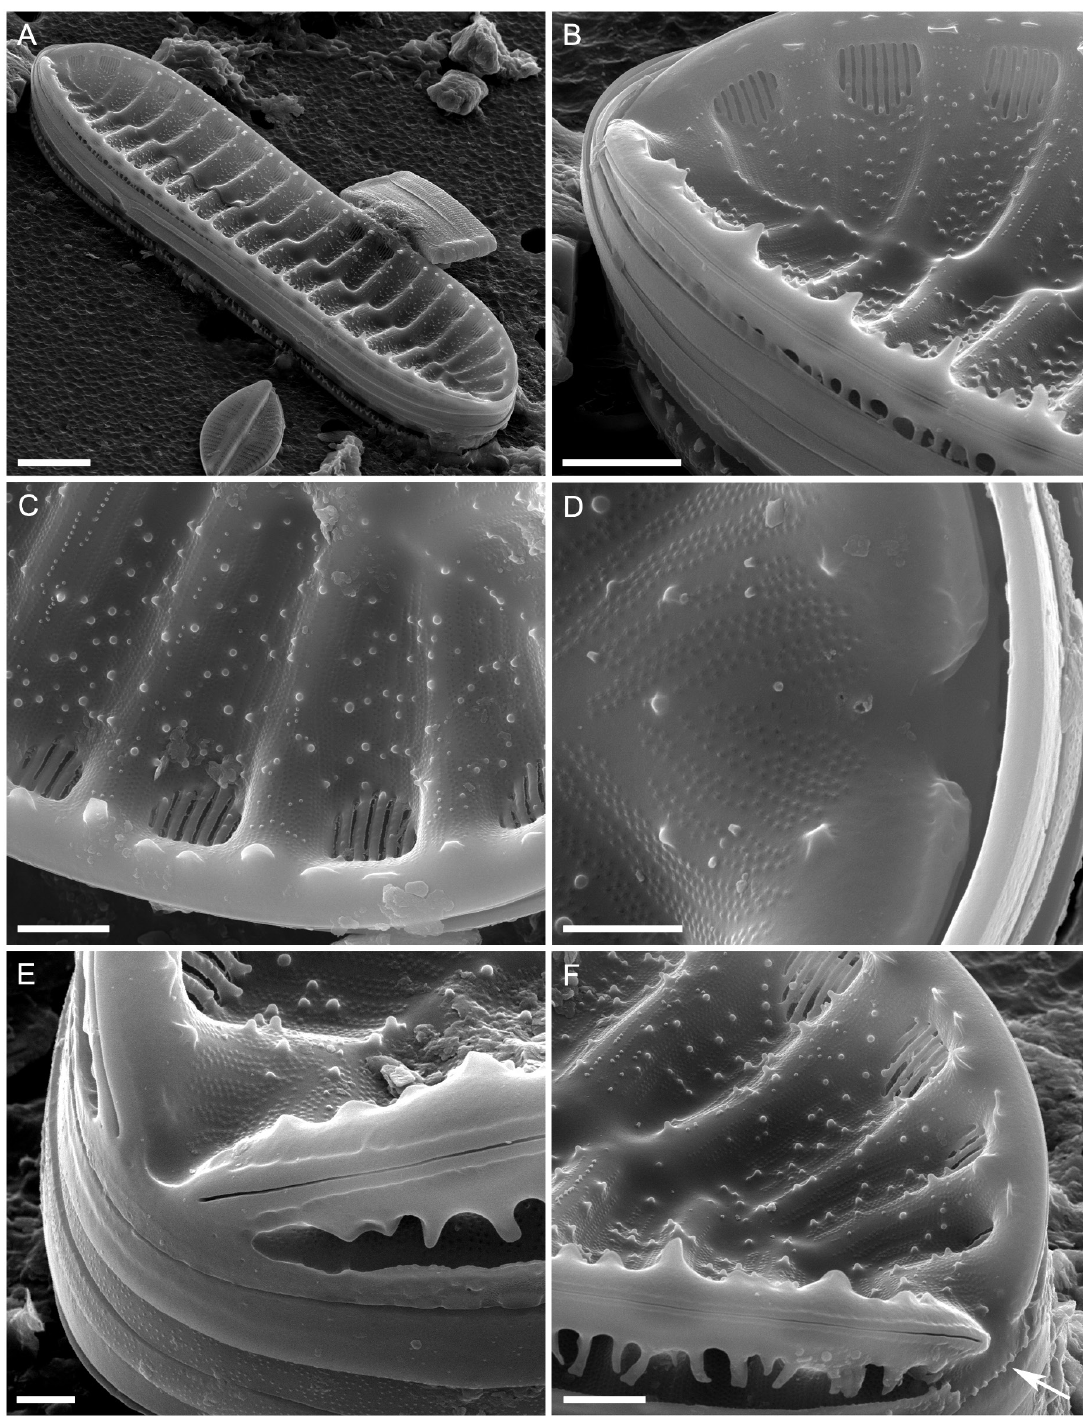
Fig. 2. Surirella ebalensis sp. nov., type material from sample CCA 2070, Lomami River, DR Congo, SEM. External view. B, C, F = detail of the raphe keel with blunt spines orientated towards the valve face and which are draped over a large part of the indented mantle side. A . Overview. B–C . Detail of the valve ornamented with silica granules and blunt spines. D . Detail of the apical pole, showing the curved raphe endings. E–F . Detail of the foot pole showing the straight raphe endings. F . Short spherical shaped silica elements near the pole (arrow). Scale bars: A = 10 µm; B = 4 µm; C, F = 2 µm; D–E = 1